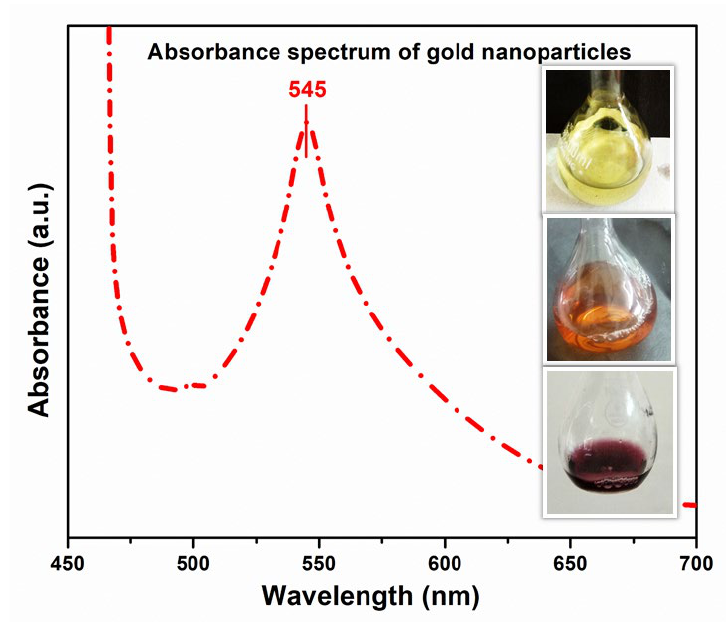
Figure 1. UV-Vis spectrum of the reaction mixture containing gold nanoparticles (AuNPs).